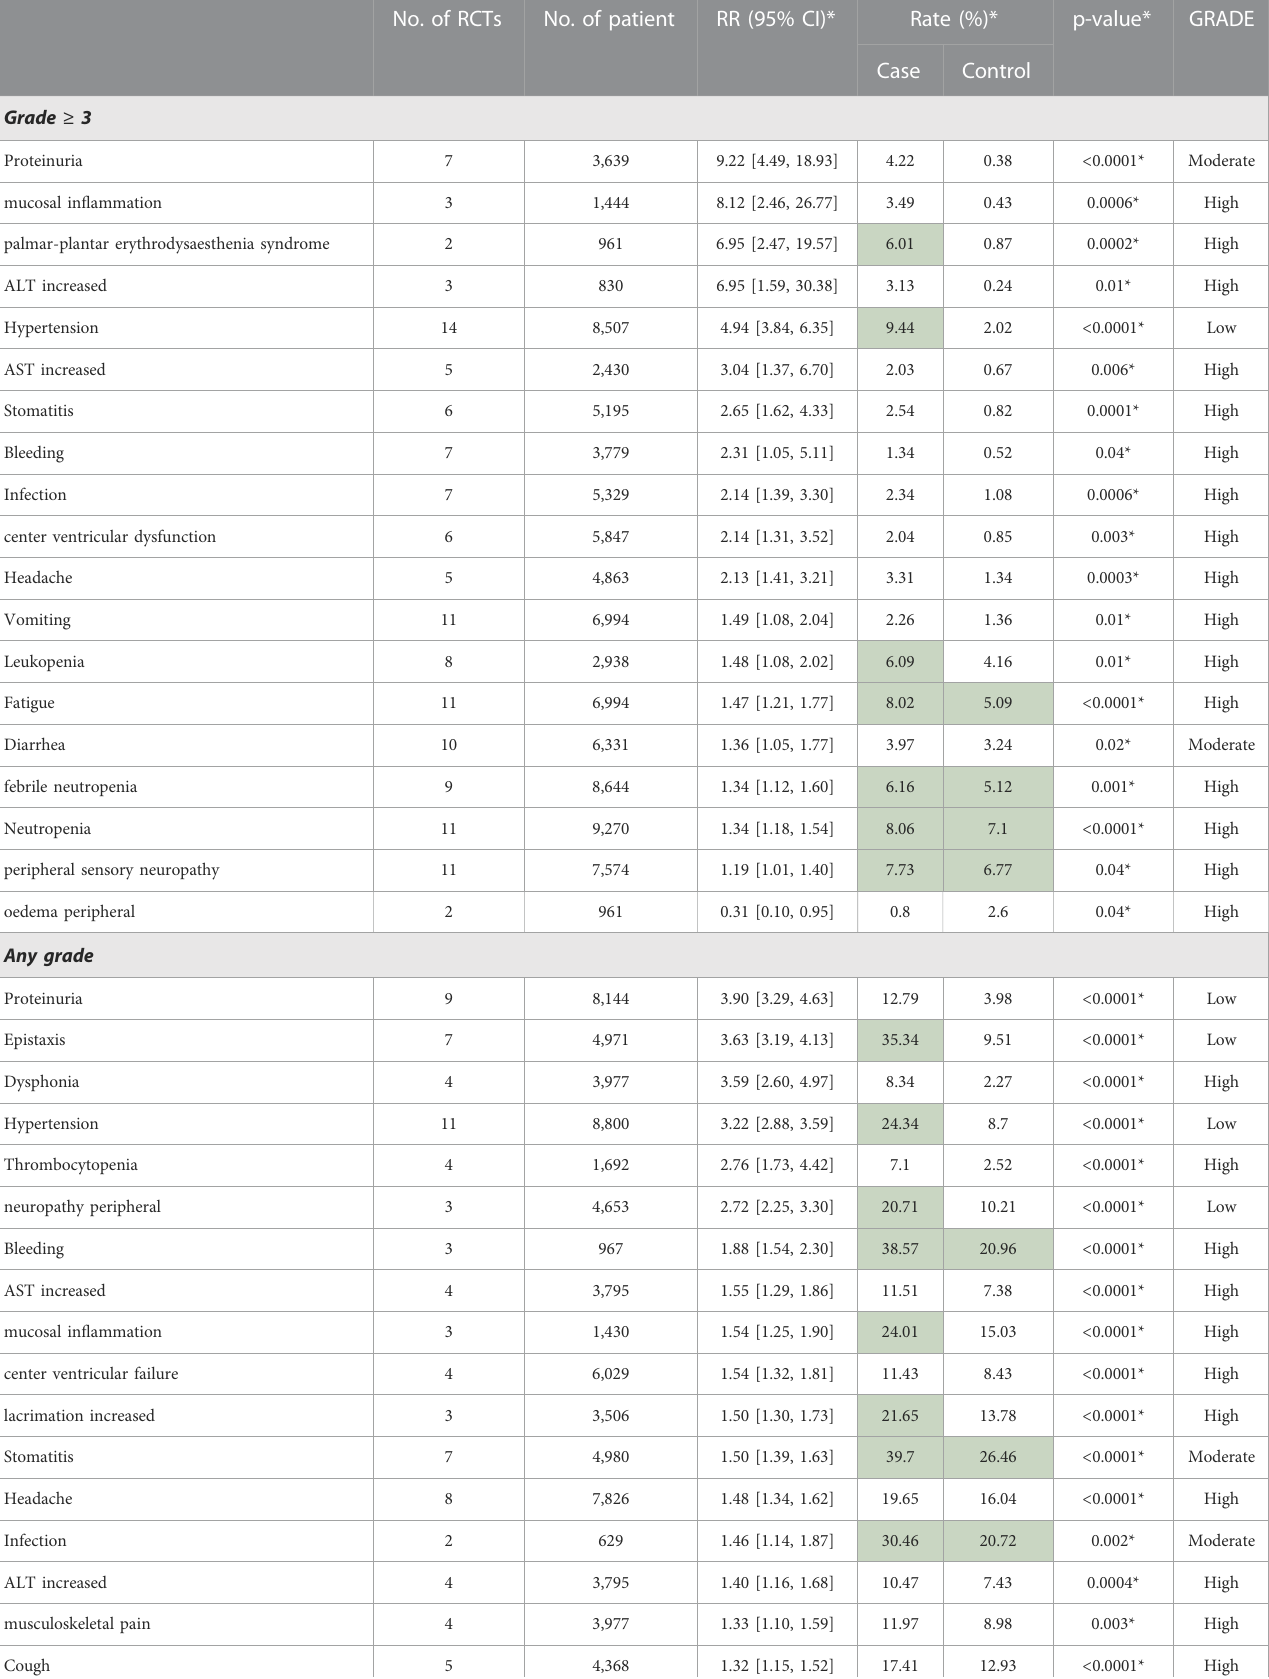
TABLE 3 Total outcome. No. of RCTs No. of patient RR (95% CI)* Rate (%)* p-value* GRADE